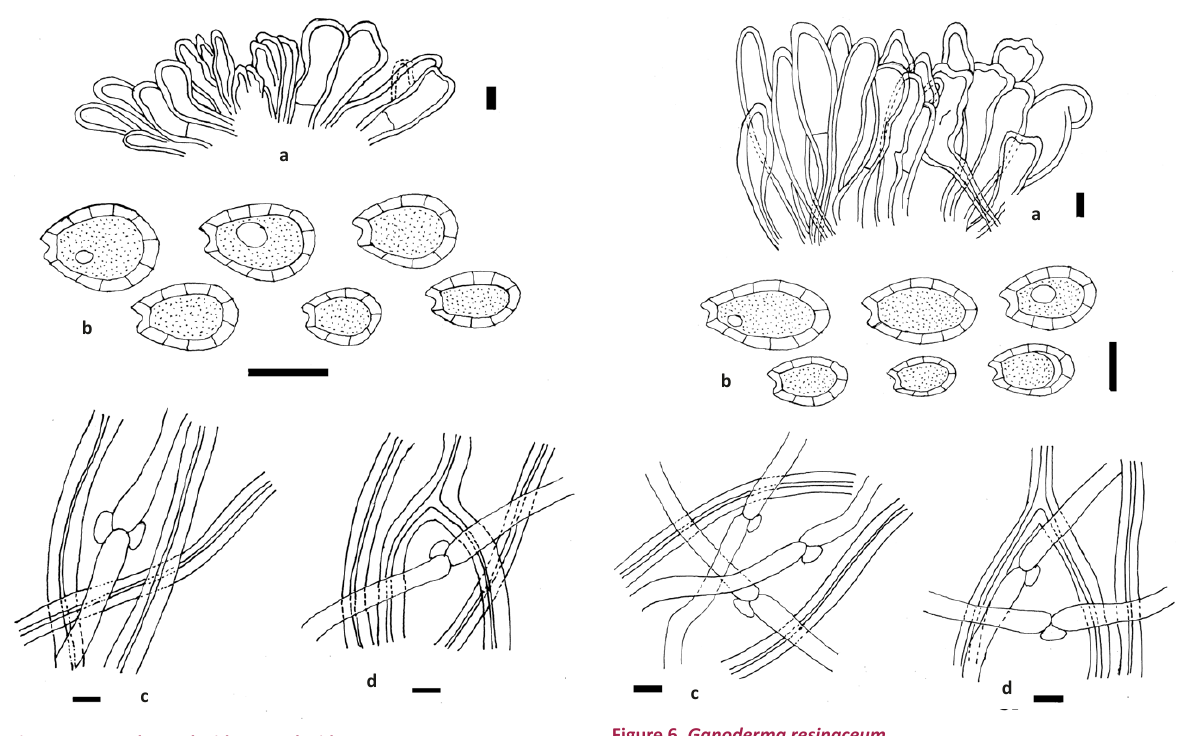
50 × 40 mm in diameter and 10–13 mm thick. Upper surface reddish-brown (8E8) with shiny concentric zones, irregular, laccate, darker (8F8) towards base. Margin thin, whitish (1A1) in colour, dark brown (7F7) on bruising. Pore surface white (1A1), dark brown (7F7) on bruising, pore circular, 3–4 per mm. Tubes not stratified, 5–7 mm deep, reddish-brown (8E4). Context double Pileus flabelliform, layered, upper brown (7E7) and lower reddish-brown